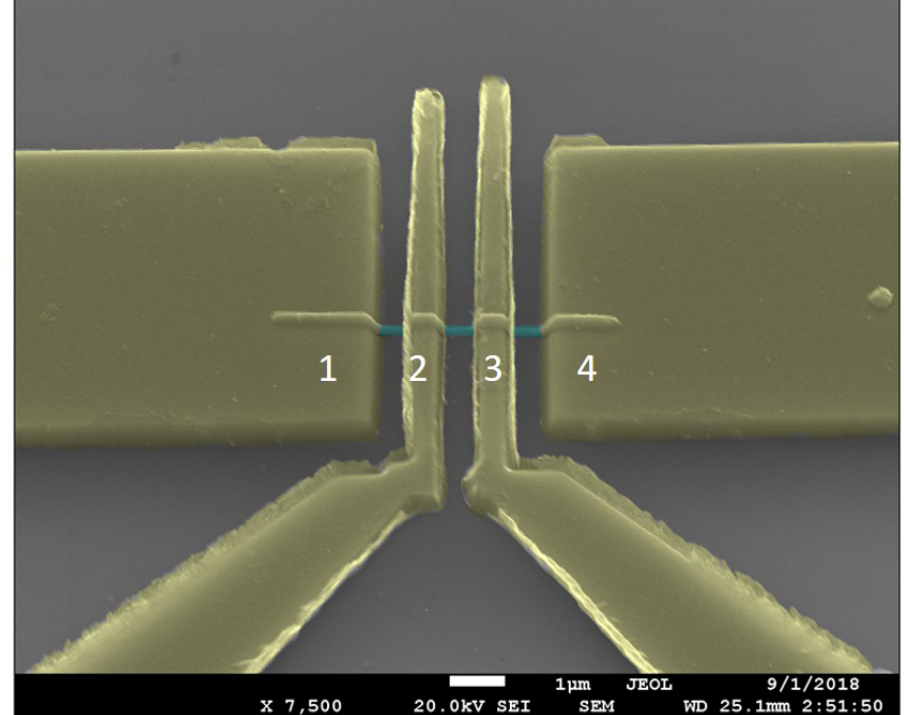
Figure 10. SEM image of single InSb nanowire contacted by four Ni electrodes. The nanowire was placed on a 200 nm thick silicon dioxide ( SiO 2 ) grown over a highly doped p + Si substrate. The channel length between each electrode is about 1.5 µ m. The metal electrodes are Cr (5 nm)/Ni (200 nm). Cr enables better adhesion of Ni film on the SiO 2